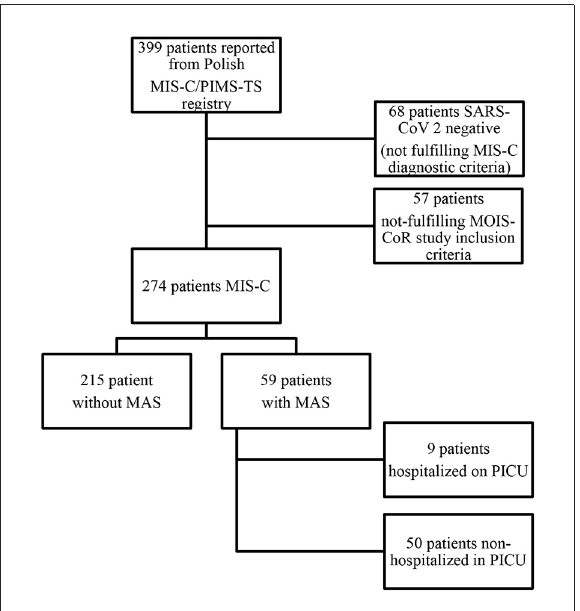
FIGURE1 Study flow diagram illustrating the patients’ inclusion process for the study.